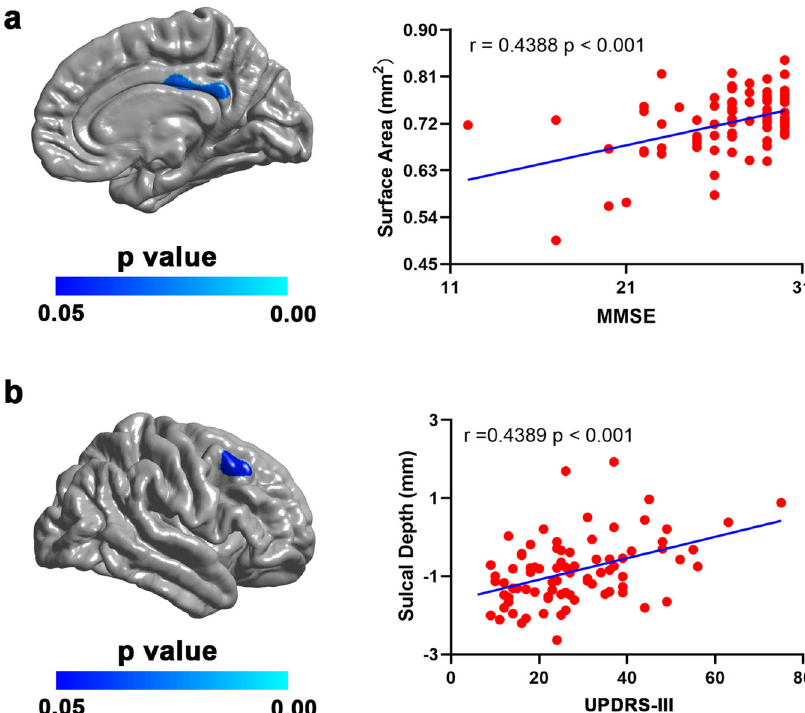
Fig. 3 Relationships between cortical morphological parameters and clinical data in patients with PD. a The left panel shows the brain region where the surface area was positively correlated with the MMSE score in patients with PD. The result was corrected for multiple comparisons using RFT. The color bar indicates the RFT-corrected p -value. The right panel is a scatterplot of the positive correlation. b The left panel shows the brain region where the Sulc value was positively correlated with the UPDRS-III score in patients with PD. The result was corrected for multiple comparisons using RFT. The color bar indicates the RFT-corrected p -value. The right panel is a scatterplot of the positive